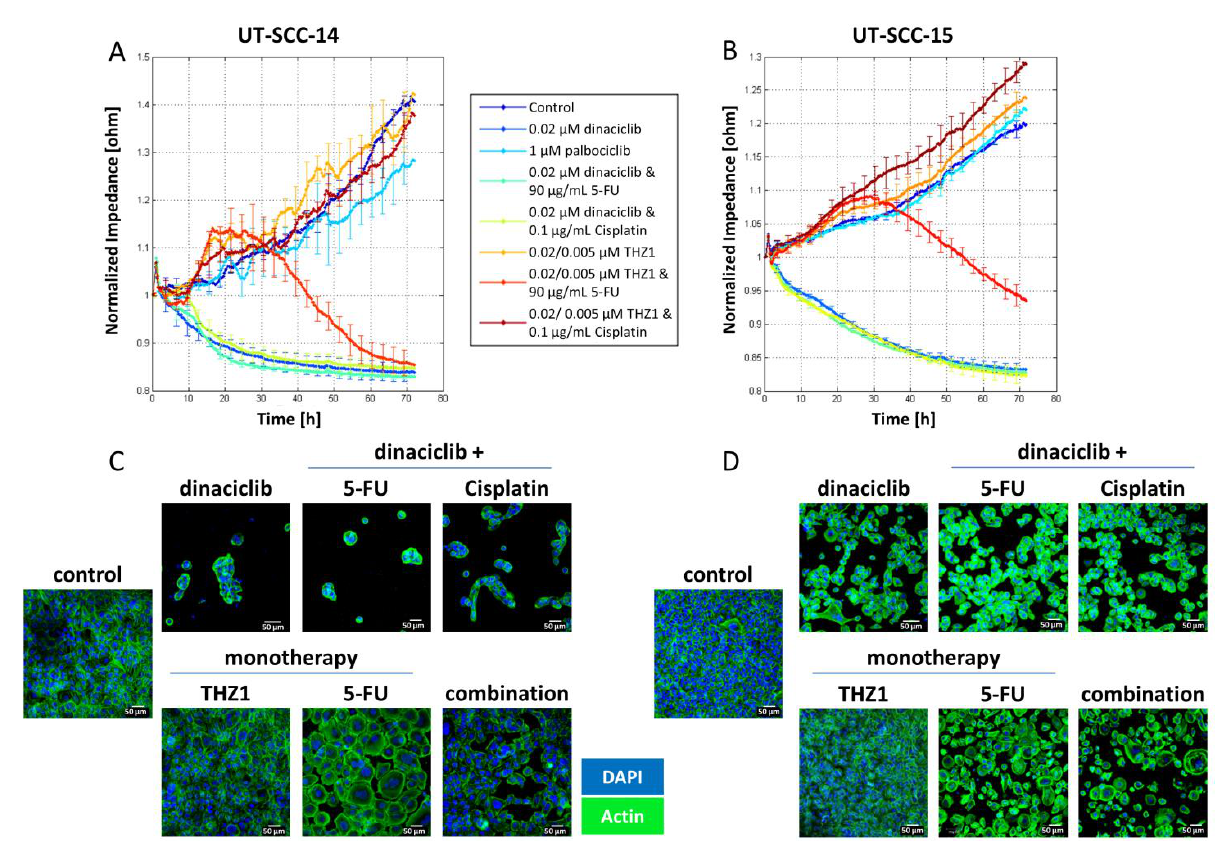
Figure 5. Impedance measurement and cytoskeletal staining. ( A , C ) UT-SCC-14 and ( B , D ) UT-SCC-15 cells. Cells were seeded in a 96-well ECIS array plate with 20 interdigitated electrodes/well and treated with selected test substances to investigate the impact of the treatment schedules. Drug doses were as follows: dinaciclib [0.02 µ M]; palbociclib [1 µ M]; THZ1 [UT-SCC14: 0.02 µ M; UT-SCC-15: 0.005 µ M]; 5-FU [90 µ g/mL]; Cisplatin [0.1 µ g/mL]. Impedance was monitored in real-time. The analysis of cell-cell contacts was performed by 4000 kHz using ECIS Software. Then, actin staining was performed with phalloidin green. Cell nuclei were stained with DAPI. Analysis was performed with a Zeiss LSM-780 Confocal Laser Microscope. Original magnification 200×.